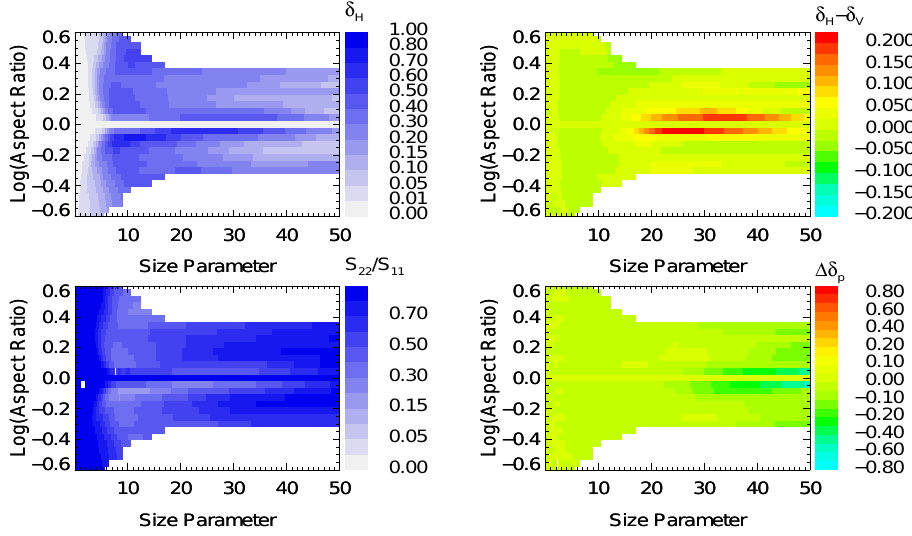
Fig. 13. Results of T-matrix calculations for spheroidal ice particles with different aspect ratios and size parameters. Upper left: linear depolarisation ratio δ H for a detection angle of 178 ◦ . Upper right: difference between the linear depolarisation ratios for parallel (H) and perpendicular (V) incident laser polarisation. Lower left: normalised Mueller matrix element S 22 /S 11 for a detection angle of 178 ◦ . Lower right: difference in δ p for the detection angles 178 ◦ (SIMONE) and 180 ◦ (lidar) using Eq. (13). Negative values indicate higher δ p ratios at 180 ◦